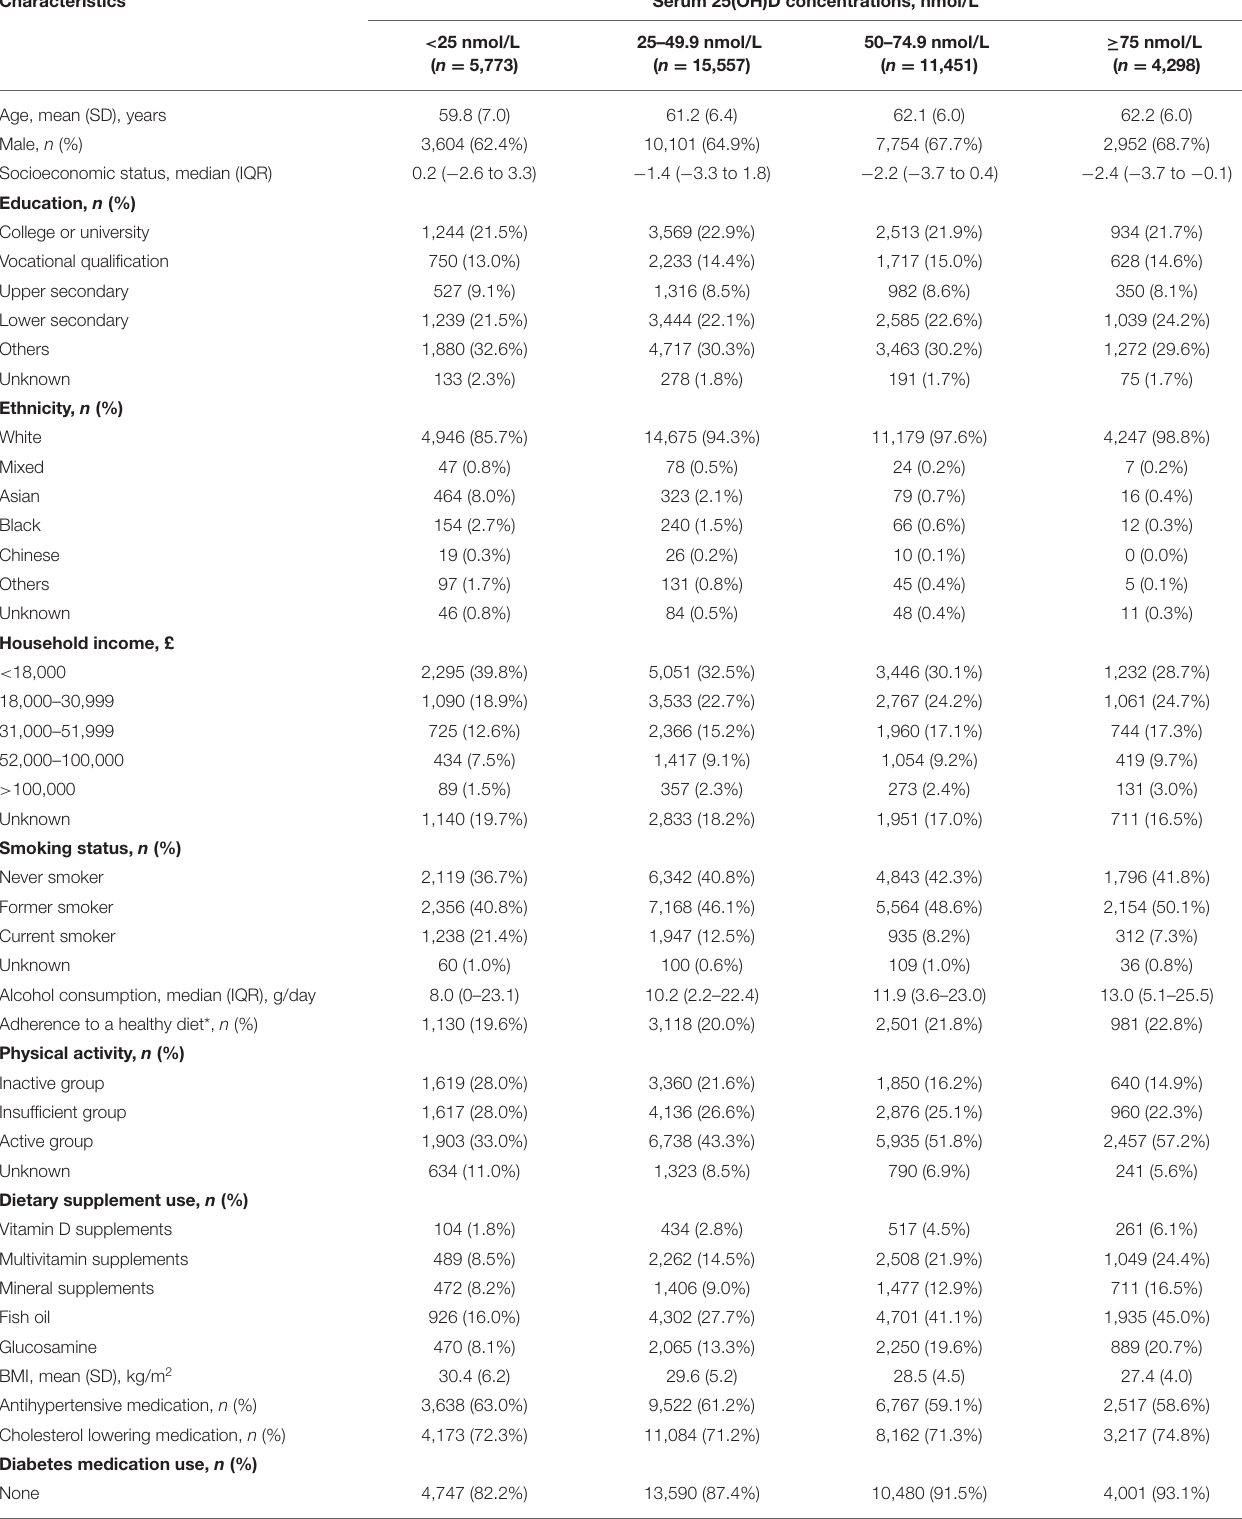
TABLE 1 | Baseline characteristics of 37,079 patients with cardiovascular disease in UK Biobank.